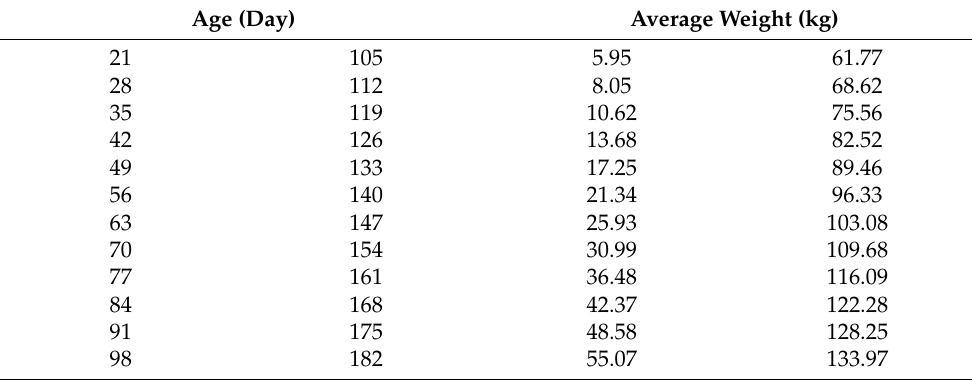
Table 1. Database sample of age and pig live weight.